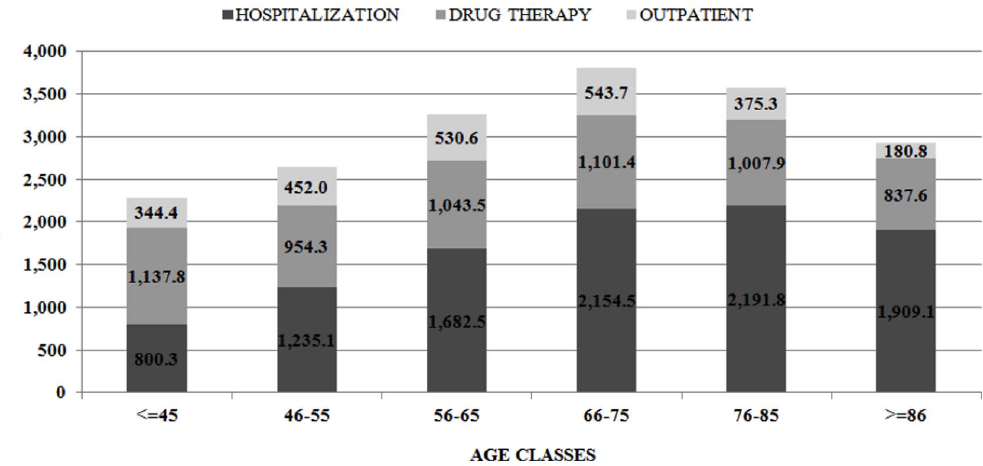
Figure 4. Distribution of overall costs ( J /patient-year) by age classes, according to the three main cost categories: hospitalization, drug therapy and